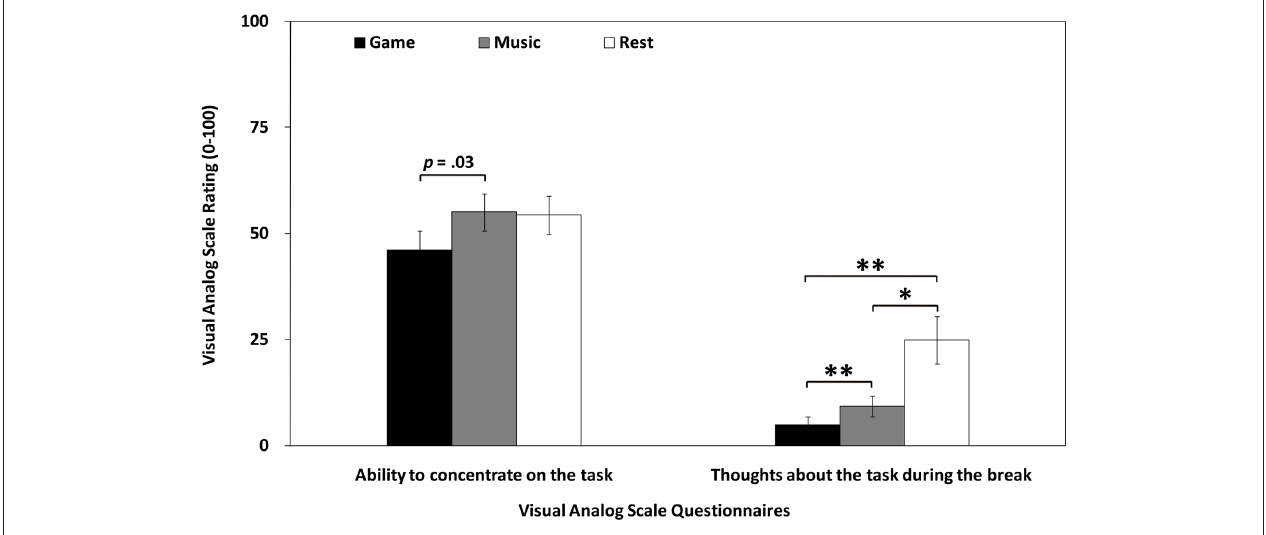
FIGURE 2 | Mean self-rated visual analog scores for game, music and rest conditions. Visual analog scales (VAS) were adapted from Bond and Lader (1974). Error bars represent standard errors of the mean. * p < 0.02 and ** p < 0.003 (two-tailed) after Bonferroni correction for multiple